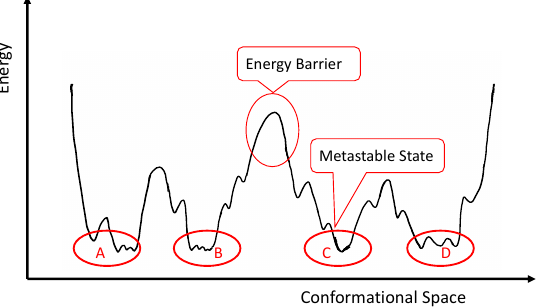
Figure 1. An illustration of the free energy landscape of a conformational space. There are four metastable states labeled as A, B, C and D. Conformations belonging to one metastable state, for example state B, do not easily change into conformations belonging to another metastable state, e.g., state C, due to the energy barrier between